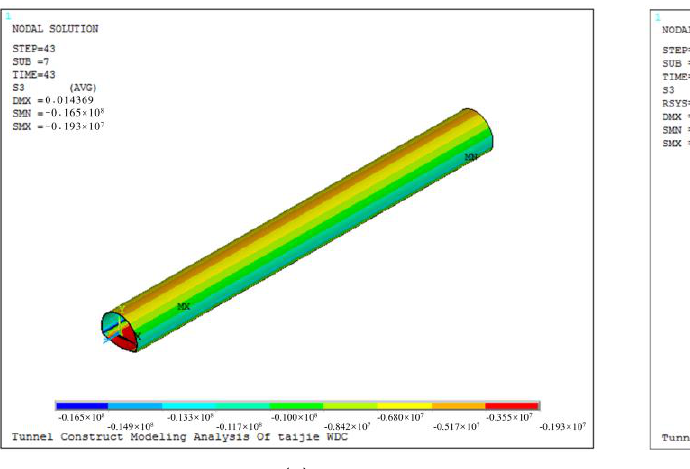
Figure 18. Vertical displacement curve of the lining for different fault dip (the data come from the situation of the 10 cm fault dislocation in [14]). Owing to the limited operating space and difficulties in realizing multi-step excava- tion and lining, this test could only complete the excavation and support of the model in one step. During the test, the response mechanism of the tunnel was observed. After the right part lining was constructed, the spandrel and vault bore most of the surrounding rock pressure. When the left part lining was constructed, the surrounding rock pressure on the vault decreased below the unexcavated state, and the bilateral spandrels became the main bearing parts. After the removal of the middle wall, the surrounding rock pres-